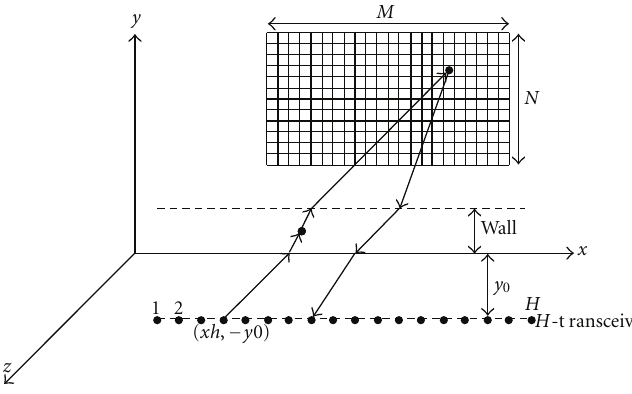
Figure 1: Geometrical representation of